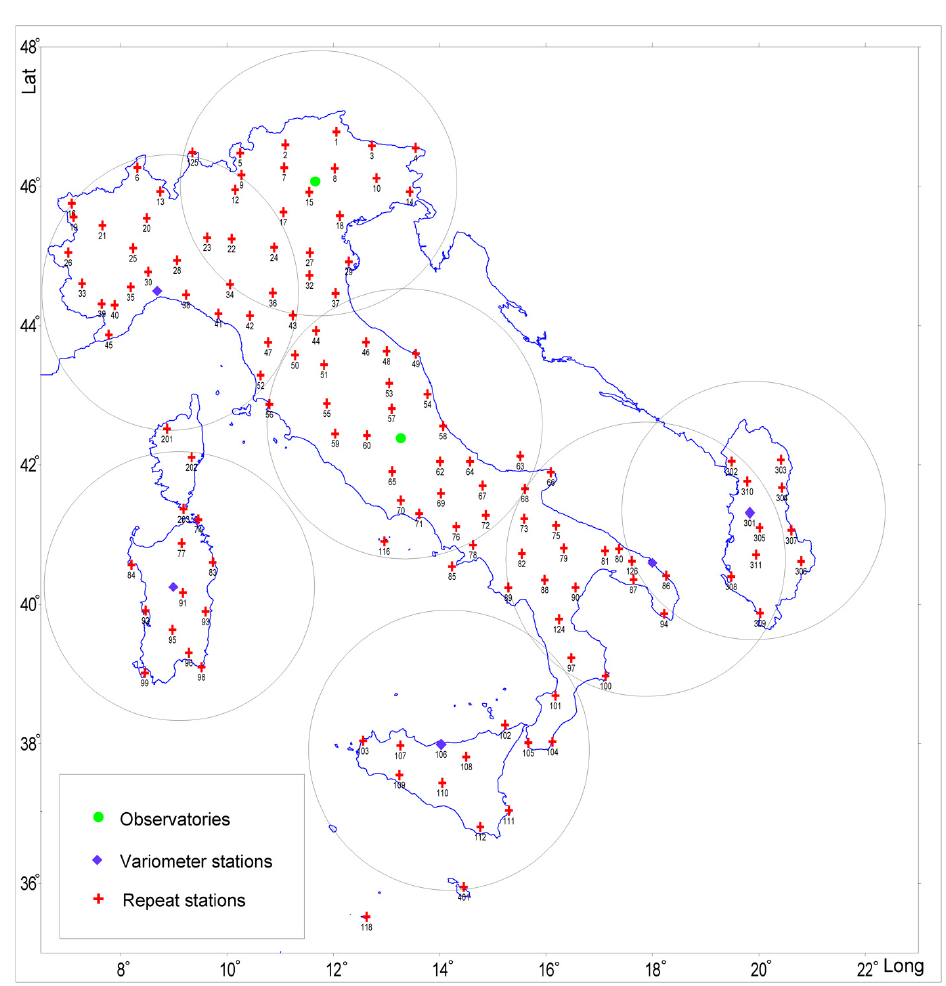
Figure 1. Italian repeat station network. Red crosses indicate repeat stations, filled circles indicate observatories and diamonds indicate variometer stations; large circles indicate coverage areas for rapid time variations as recorded at observatories and variometer